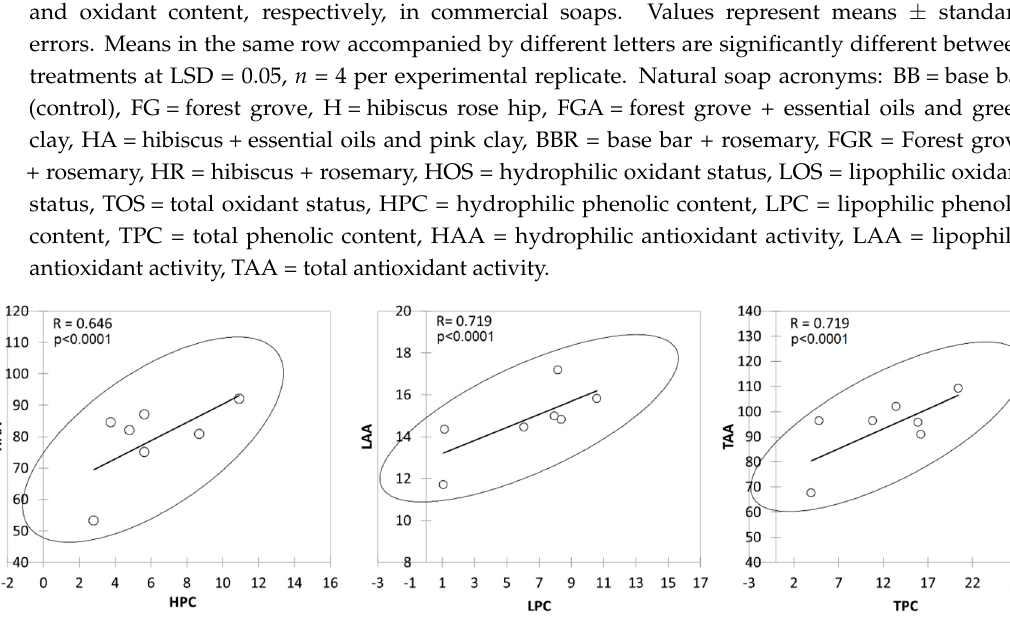
Figure 5. Scatter plots showing relationships between the phenolic content and antioxidant activities in different commercial natural soaps after cold saponification. HPC = hydrophilic phenolic content, LPC = lipophilic phenolic content, TPC = total phenolic content, HAA = hydrophilic antioxidant activity, LAA = lipophilic antioxidant activity, TAA = total antioxidant activity.